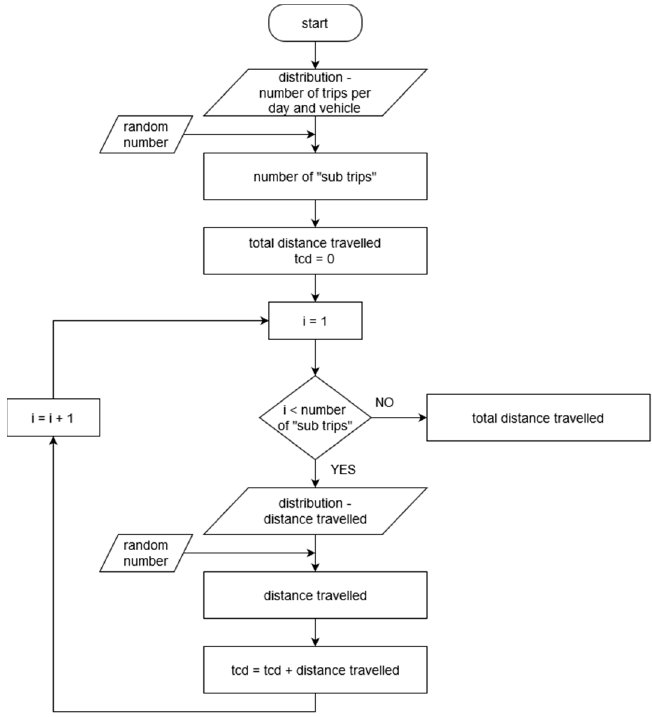
Figure 6. Determination of total distance travelled for each trip of the selected user groups.